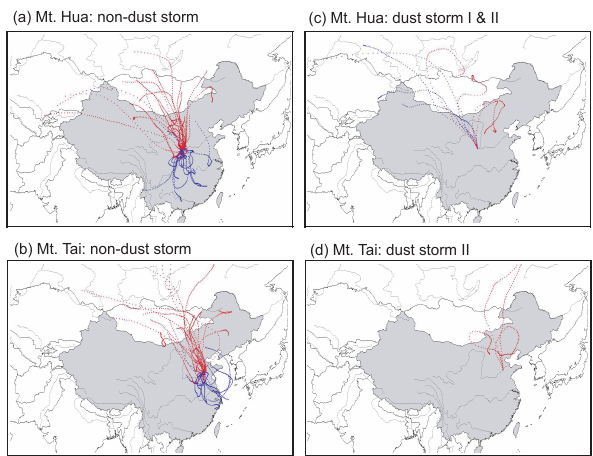
Fig. 7. 72-h Backward trajectories of air masses arriving in Mt. Hua Figure 7. 72-hr Backward trajectories of air mass arriving in Mt. Hua and Mt. Tai during the non-dust